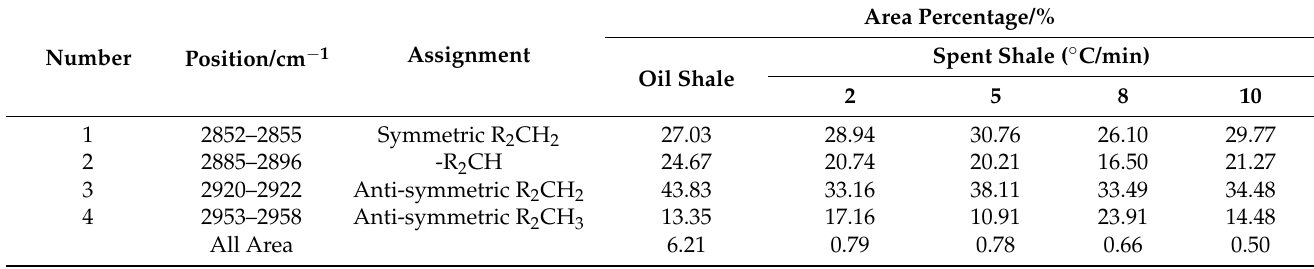
Table 4. Variation of functional groups during pyrolysis in the aliphatic region of the Jimsar oil shale.